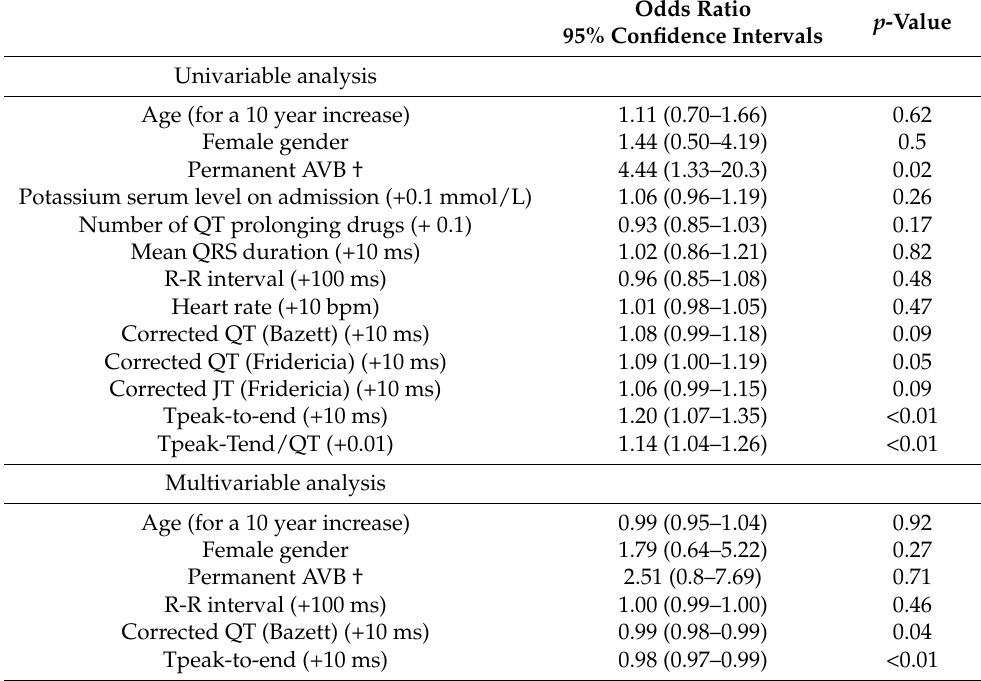
Table 2. Summary of univariable and multivariable analysis (logistic regression) with